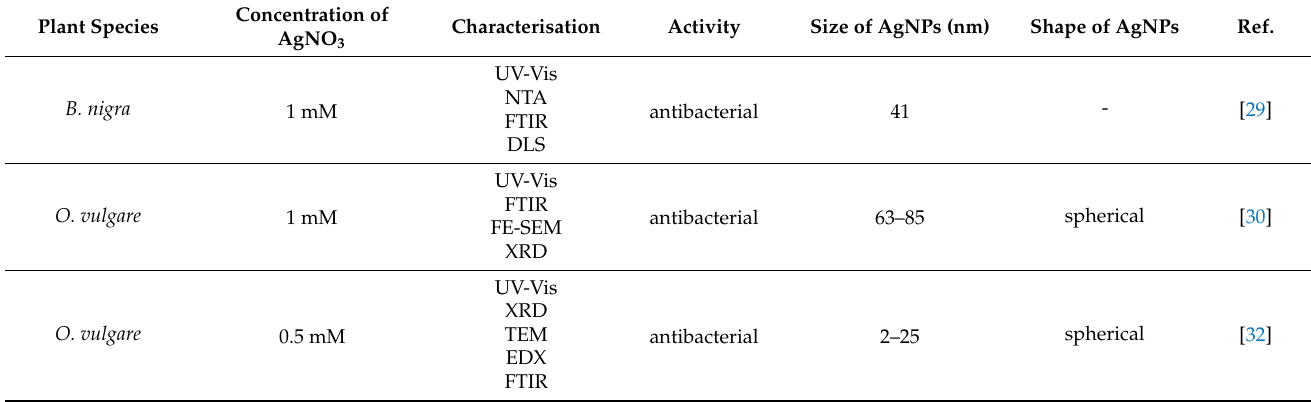
Table 1. Summary table of the main findings of the studies performing green synthesis using the selected plants. Concentration of Plant Species Characterisation Activity Size of AgNPs (nm) Shape of AgNPs AgNO 3